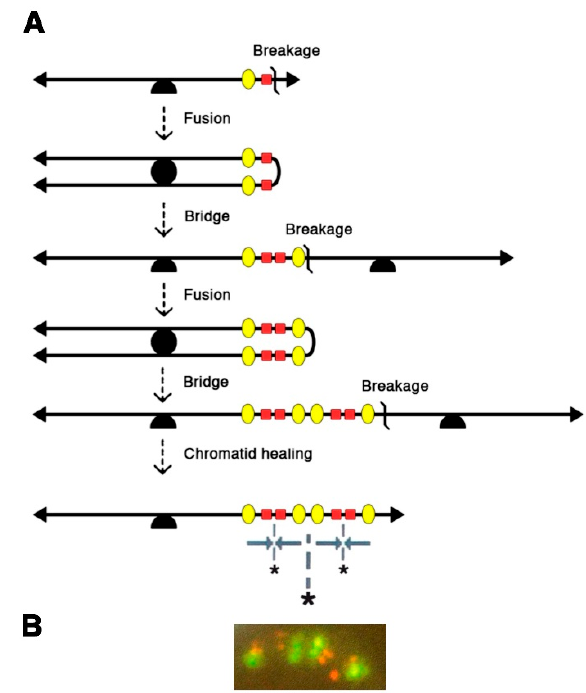
Figure 2. Chromatid Breakage-Fusion-Bridge cycles account for the symmetrical structures observed at early stages of gene amplification in mammalian cells. ( A ) At the earliest stages of gene amplification, breakage-fusion-bridge (BFB) cycles of sister chromatids lead to megabase-long palindromes with one or two orders of symmetry, containing equal copy numbers of the amplification driver gene (conferring drug resistance; red squares) and of the passenger marker (yellow ovals, centromeric to the driver in an unamplified chromosome). Grey arrows: orientation of amplified units; asterisks: symmetry axes; arrowheads: telomeres; half-circle: centromere. ( B ) Example of a palindromic structure observed on an AMPD2 -amplified metaphase chromosome. This structure was revealed by two-color FISH with a digoxigenin-labelled probe for the amplification driver AMPD2 (in red) and a biotinylated probe for P3C4, a passively co-amplified marker (in yellow). Adapted from Figures 2 and 4 of ref. [4].